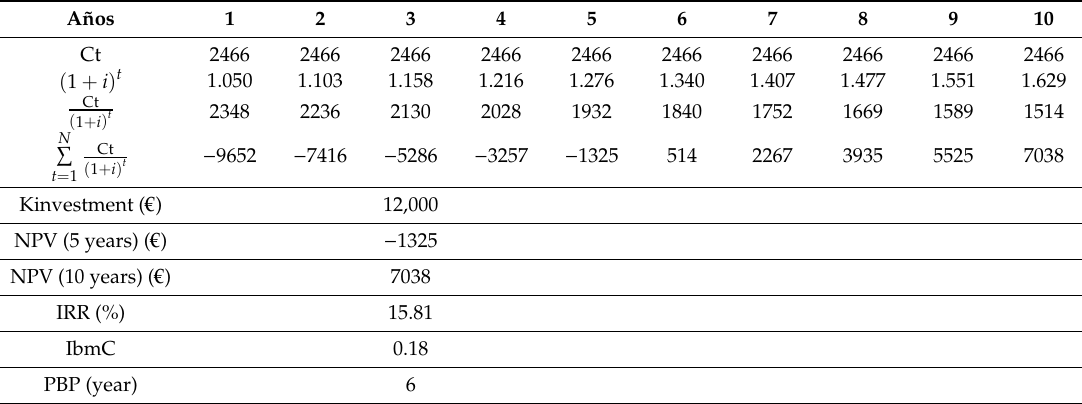
Table 15. Economic analysis results (80% olive and 20% plastic) (Source: own